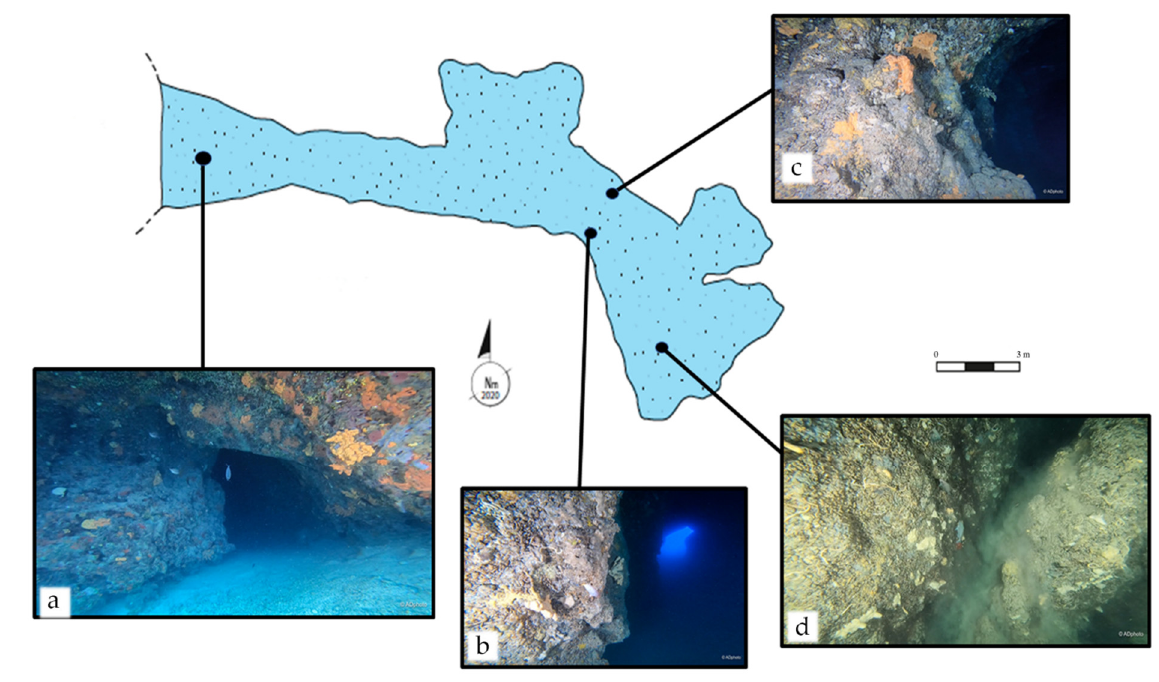
Figure 1. Sampling stations in the cave: ( a ) Entrance (ES), ( b ) right wall of the intermediate sector (IS) with the view of the entrance in the background, ( c ) left wall in the intermediate sector, and ( d ) crack in the wall in the innermost area of the cave, showing sediments suspended by the outflow of water (BS). Photos by Adelmo Sorci.